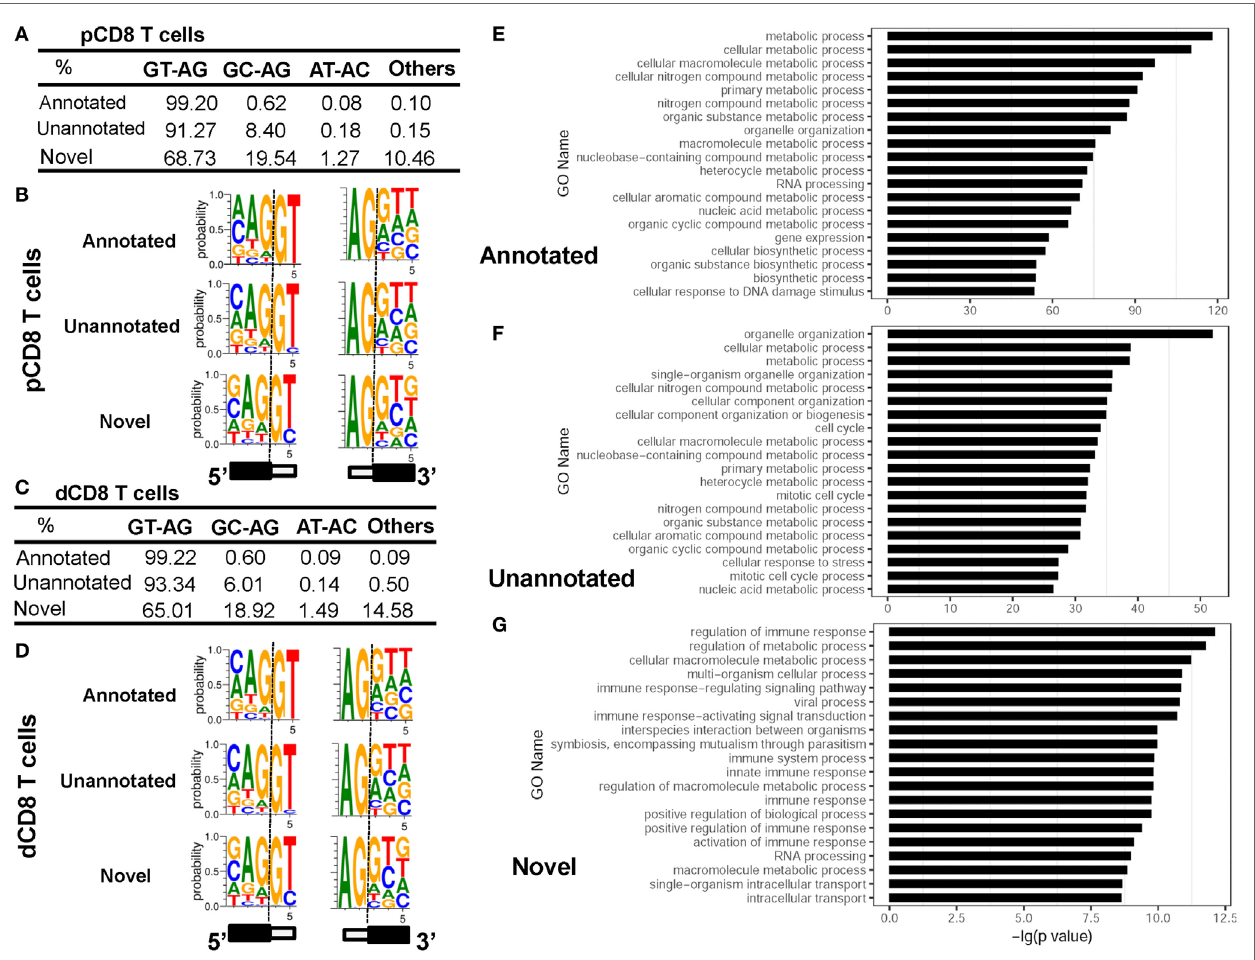
FigUre 5 | Novel splice junctions use a high ratio of the non-canonical splicing motif GC-AG and are enriched in the genes related to immune response. (a–D) Comparison of splice site motifs for annotated, unannotated, and novel splicing junctions in human pCD8 (a,B) and dCD8 T cells (c,D) . To analyze the splice site motif on each splice junction, a 5-bp sequence around each splice site (3 bp to the exon and 2 bp to the intron) was considered, and the proportion of each splice site motifs GT-AG, GC-AG, AT-AC, and others was evaluated by the number of junctional read counts. Sequence logos of splice site motifs (B,D) were generated by WebLogo (black box, exon; white box, intron). (e–g) Functional enrichment analyzed the genes containing annotated (e) , unannotated (F) , or novel (g) splice junctions and the top 20 GO terms (biological process) were indicated. Abbreviations: pCD8 T, peripheral blood CD8 + T; dCD8 T, decidual CD8 + T; %, percentage, GO, gene